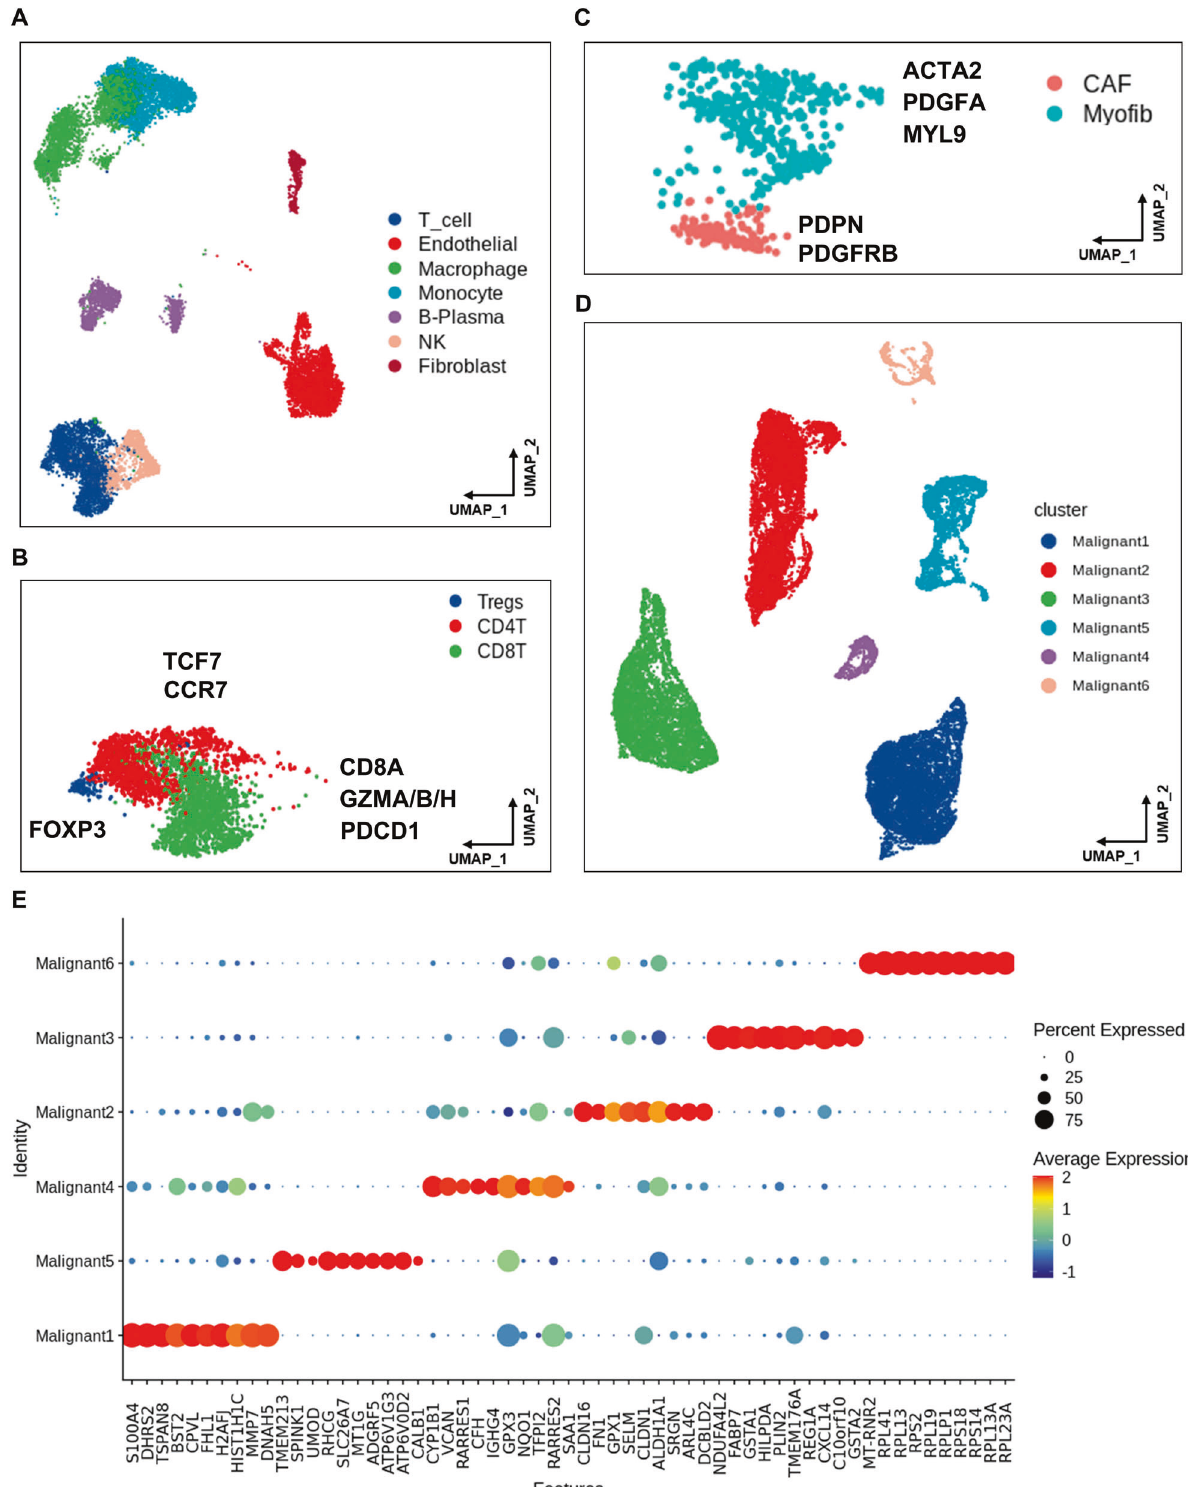
Fig. 2 RCC primary and metastatic tumors in scRNA-seq characterization. A UMAP plot of non-malignant cells, including T cells, endothelial cells, macrophages, B/Plasma cells, NK cells and fi broblasts identi fi ed by maker annotations. B Zoomed in UMAP plot of T cell cluster with CD8 + T cells, CD4 + T cells, and Tregs. Marker gens were listed. C Zoomed in UMAP plot of Fibroblasts with CAFs and Myo fi b. Marker genes are listed. D UMAP plot of malignant cells shows the Malignant 1 – 6 subsets. E Bubble plot of top 10 genes expression in Malignant 1 – 6 subsets; the size of bubble represents the percent expressed of cells; the color represents the mean expression level of each gene in clusters: red means the high expression.